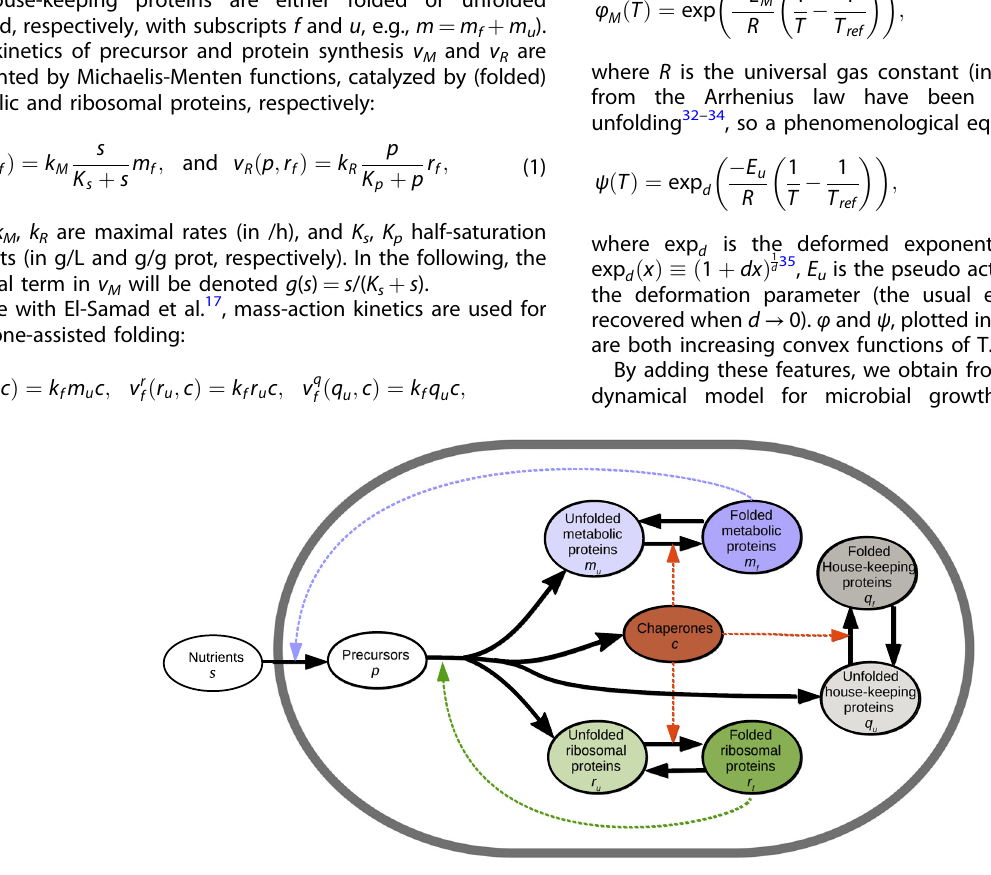
Fig. 1 Outline of the coarse-grained model. Proteins are divided into four main sectors: metabolic proteins (at mass fraction m , in units g/g prot) which convert substrate ( s ) into precursors ( p ), ribosomal proteins ( r ) which synthetize proteins, chaperones ( c ) which fold proteins, and house-keeping proteins ( q ). Within the protein sectors, apart from the chaperones, we distinguish between folded and unfolded proteins, as indicated by the indices f and u , respectively. Solid arrows refer to mass fl ows and dashed arrows to catalytic (enzymatic)